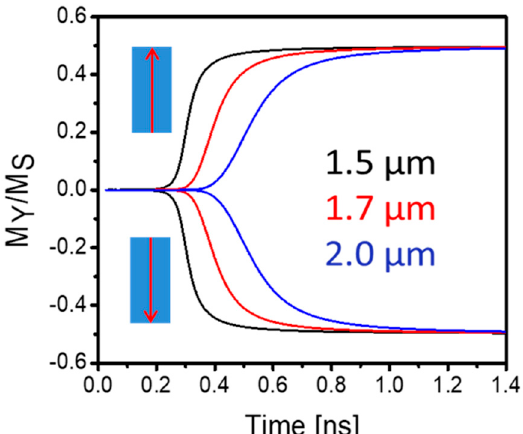
Figure 2. Results of numerical modeling showing the normalized magnetization M Y / M S as a function of time. The two sets of curves show magnetization trajectories following the initial state of the sender nano-magnet A (e.g., along or opposite to axis y ). The black, red, and blue curves show magnetization at 1.0 μ m, 2.0 μ m, and 3.0 μ m distance away from the starting point A.